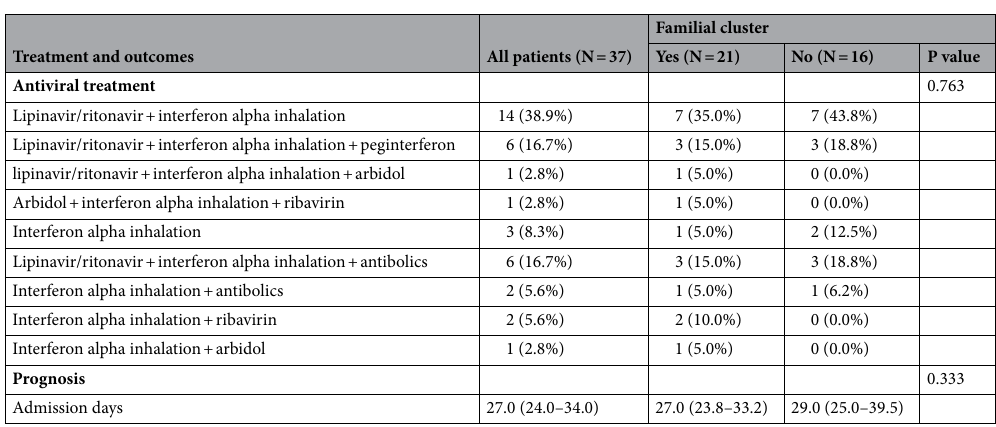
Table 3. The treatment regimens and prognosis for all the patients and the subgroup divided by family